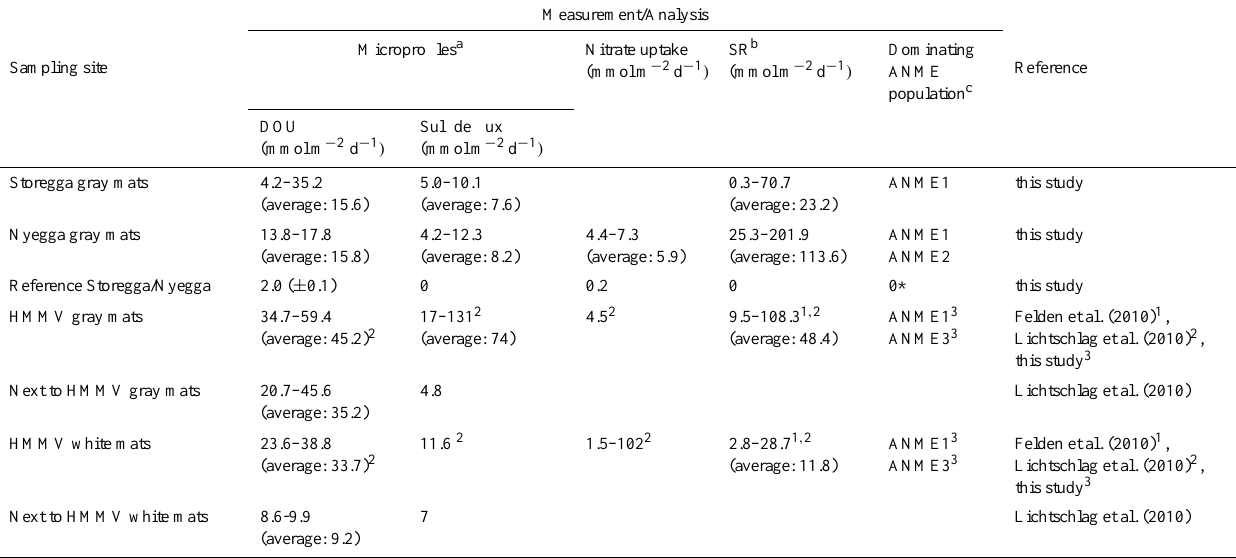
Table 2. Summary of geochemical parameters characterizing thiotrophic mats in the Storegga and Nyegga area and at the H˚akon Mosby mud